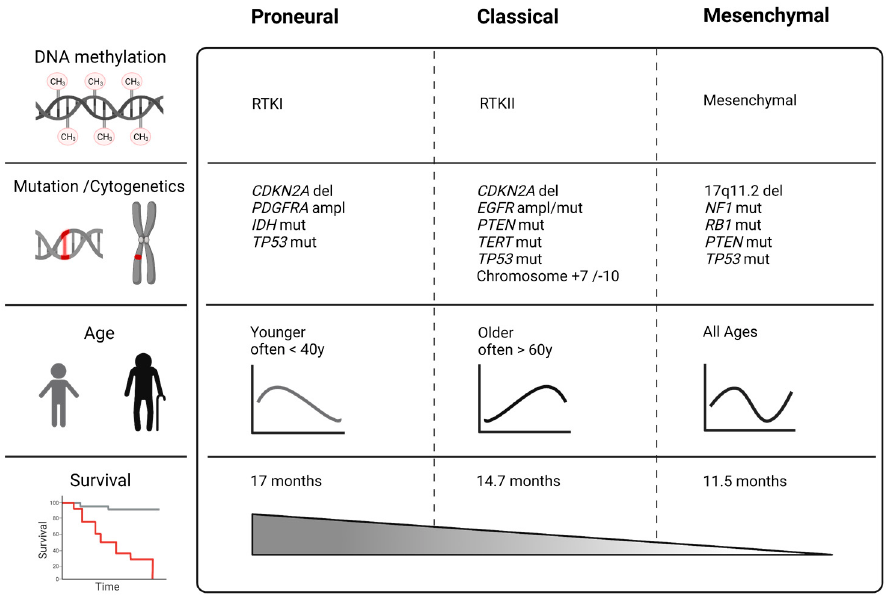
Figure 1. GBM subclasses based on The Cancer Genome Atlas (TCGA) project and Verhaak classification with the most prevalent genetic abnormalities [18]. Novel WHO classification and methylation profiling differentiate between more subgroups of malignant astrocytoma, but in comparison, the MES subtype is still associated with very poor survival. Created with BioRender (ED2349TVGA, 25.10.2021).